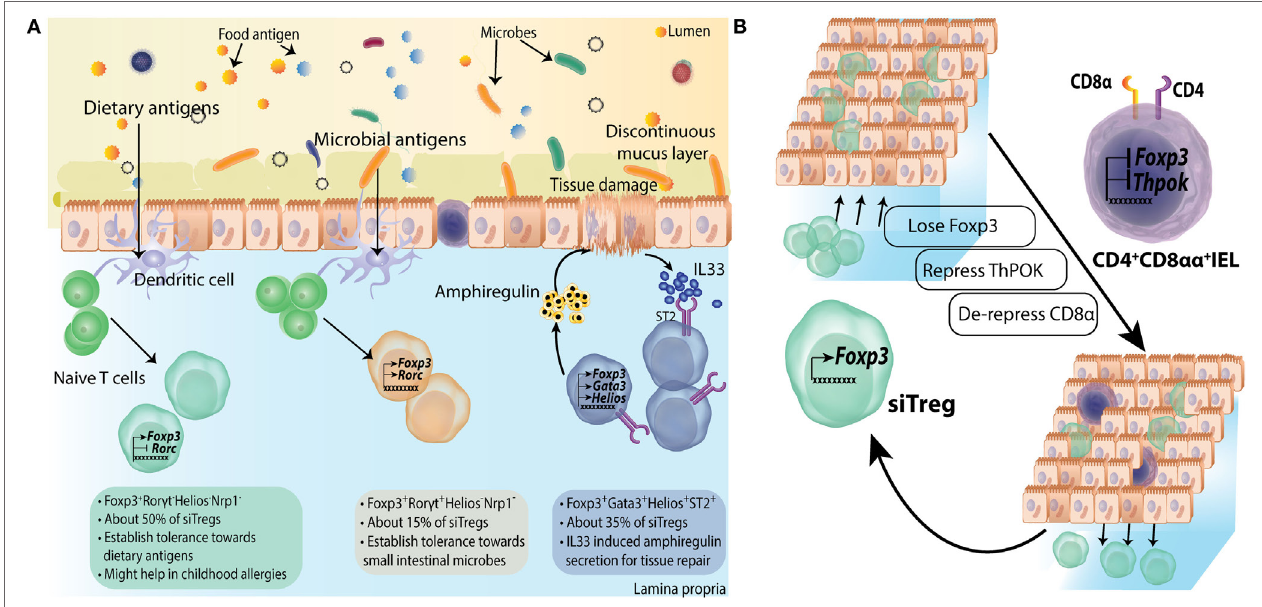
FiGURe 4 | Subtype differentiation of regulatory T-cells (Tregs) in small intestine. (A) Small intestine lamina propria (LP) Tregs are differentiated into all three subtypes mentioned in Figure 3 ; however, Foxp3 + ROR γ t − Tregs are primary population forming about 50% of siTreg compartment. They are primarily generated in response to dietary macromolecules and are proposed to be helpful in containing childhood allergies. Foxp3 + ROR γ t + and Foxp3 + GATA3 + Tregs are about 15% and 35% of total siTregs, respectively. (B) Some siTregs continuously traverse in and out of small intestinal epithelial compartment. While most of these Tregs return back to LP, a fraction of these lose their Foxp3 expression and repress ThPOK expression inside epithelial layer. They subsequently, de-repress CD8a locus to convert into CD4 + CD8 αα + double positive intra epithelial